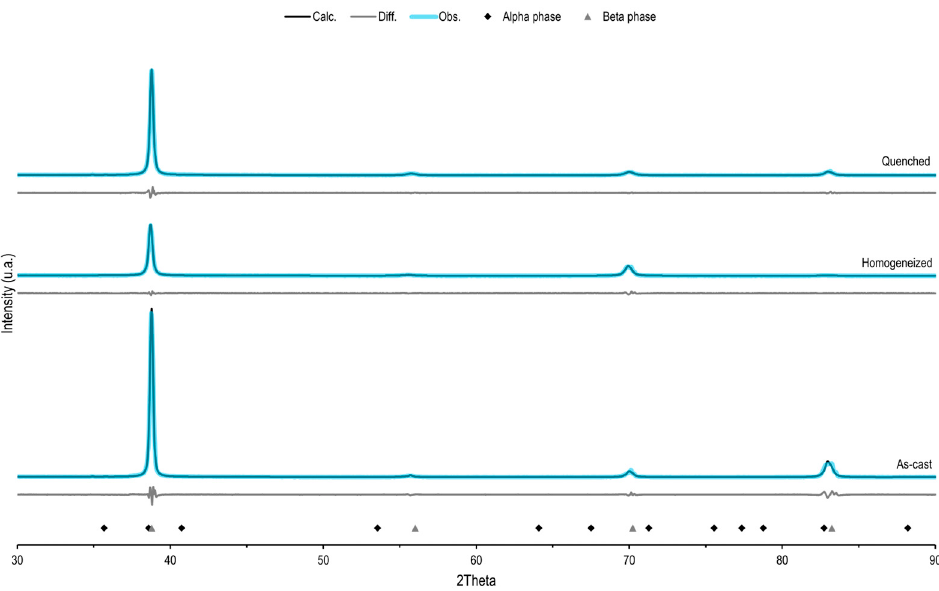
Table 1. The concentrations of the phases and lattice parameters were obtained by Rietveld refine- ment.